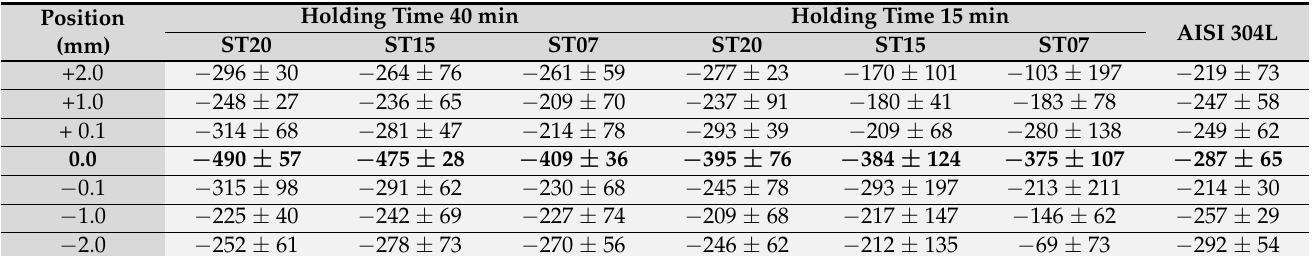
Table 5. Residual stresses, measured according to Figure 4a. Holding Time 40 min Holding Time 15 min